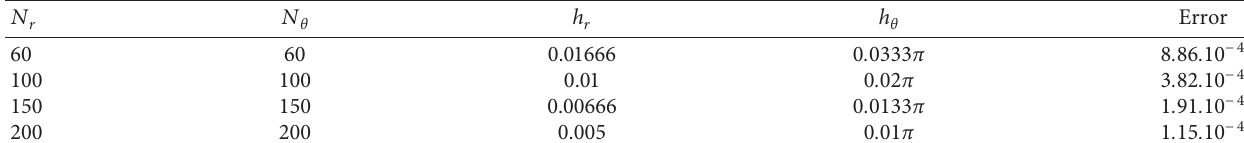
Table 5: The infinite error, using several values of N